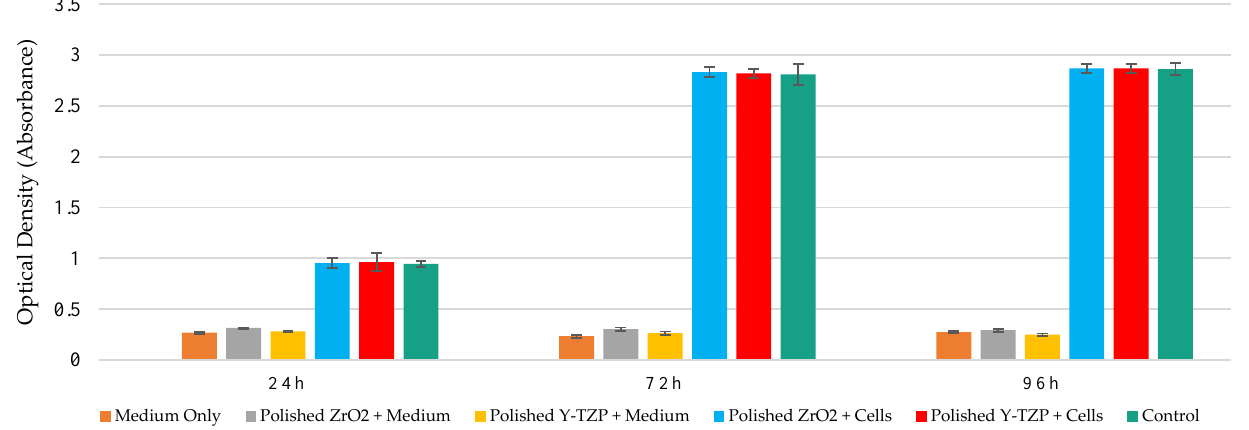
Figure 5. Metabolic activity monitoring (WST1 assay) of Saos-2 cells exposed to mirror-polished surfaces (Ra = 0.01 µm) of ZrO2 and Y-TZP for 24 h, 72 h, and 96 h (N = 4). ANOVA: Analysis of one-factor variances (ZrO2 vs. Y-TZP vs. controls). Not Significant at 24 h, 72 h, or 96 h.